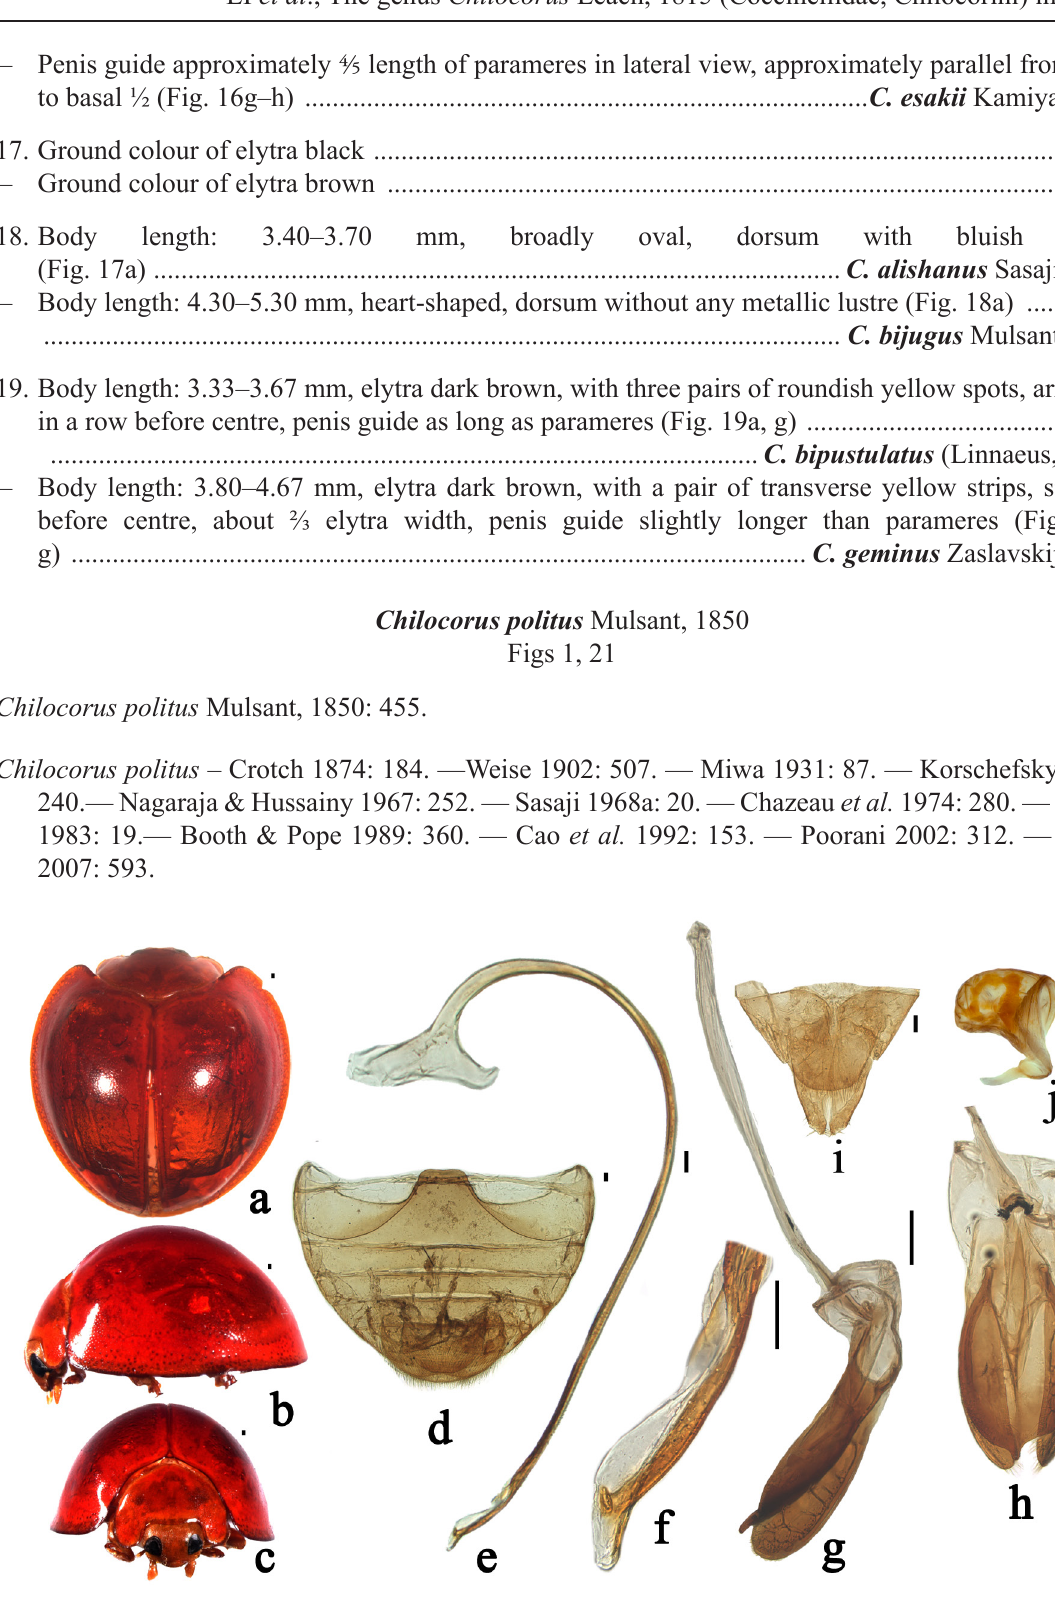
Fig. 1. Chilocorus politus Mulsant, 1850. a . Dorsal view. b . Lateral view. c . Frontal view. d . Abdomen. e . Penis. f . Apex of penis. g . Tegmen, lateral view. h . Tegmen, ventral view. i–j . Female genitalia. i . Ovipositor. j . Spermatheca. Scale bars: 0.1